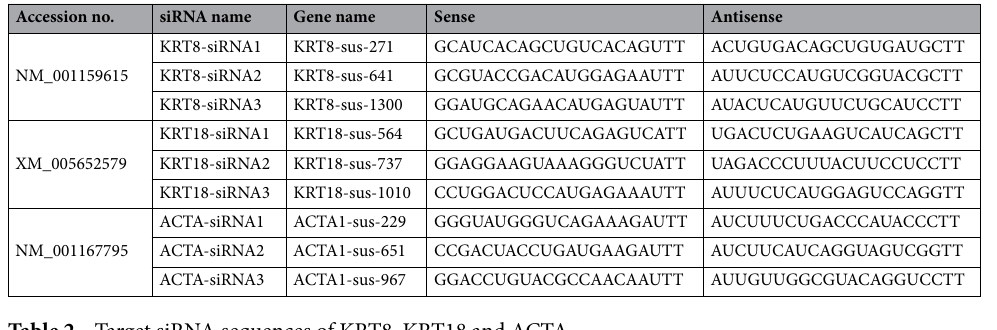
Table 2. Target siRNA sequences of KRT8, KRT18 and ACTA.